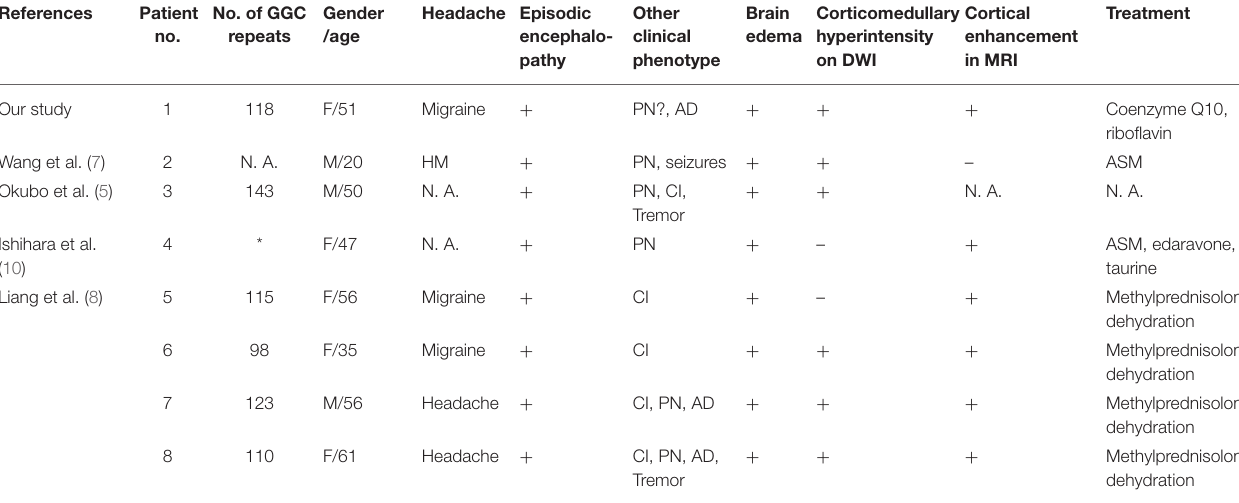
TABLE 1 | The clinical and brain MRI features of NIID patients with MELAS-like episode. Patient